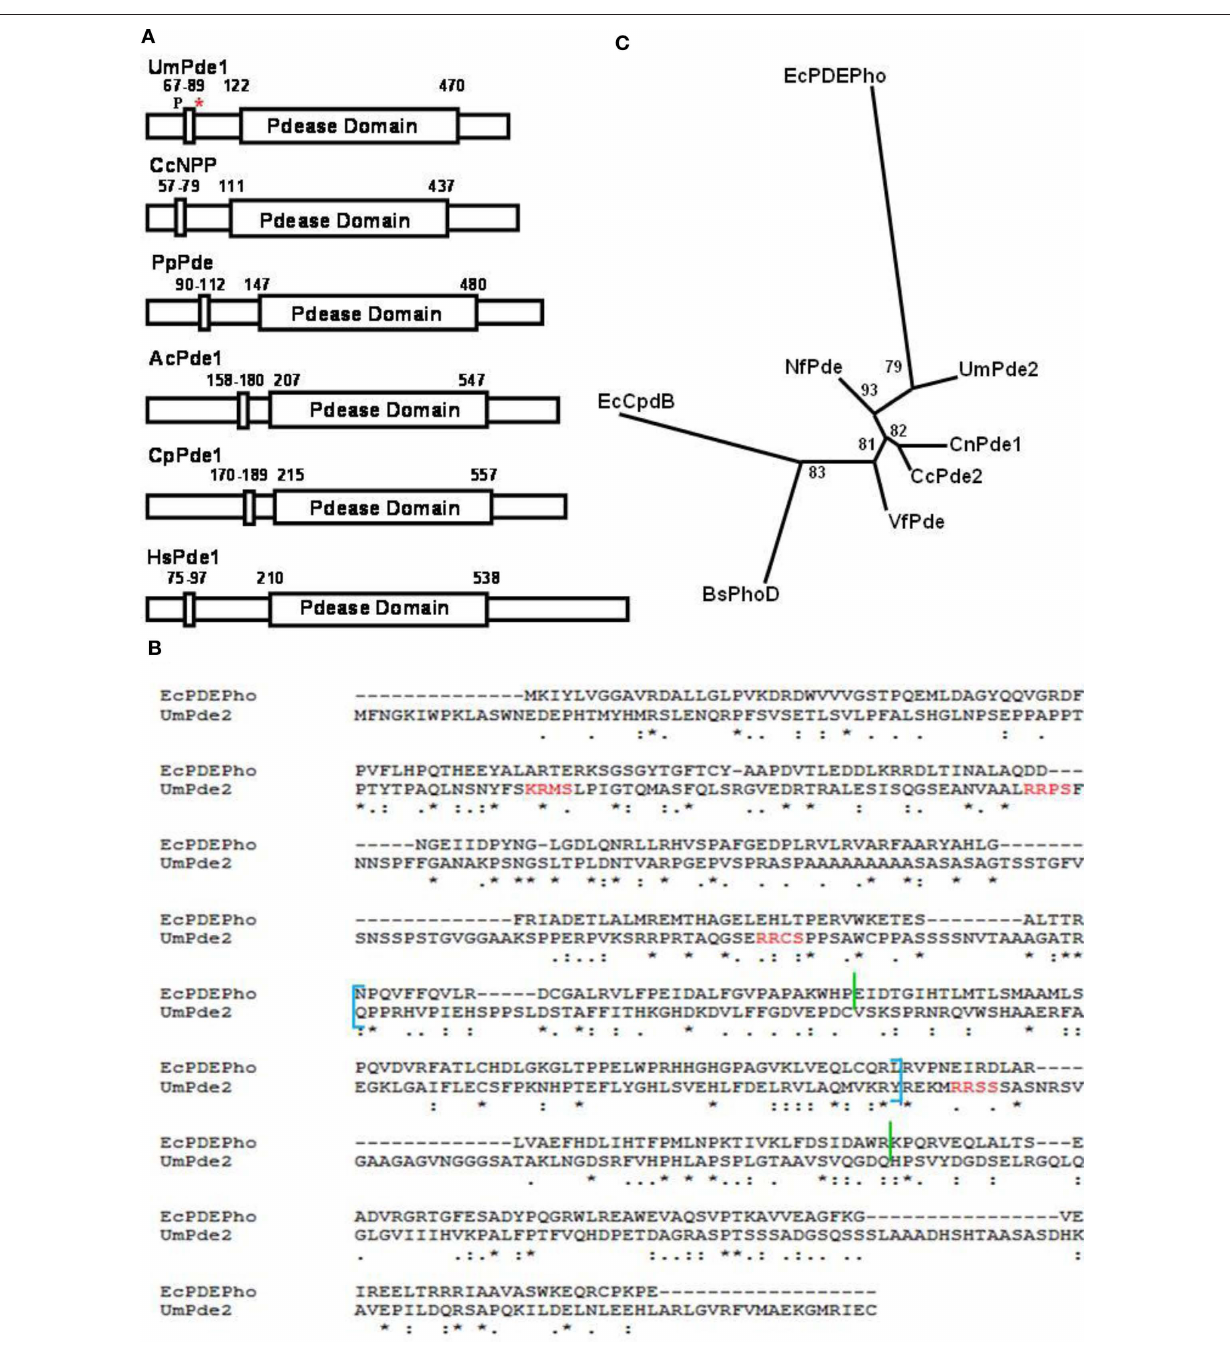
transferase and 2 ′ 3 ′ -cyclic phosphodiesterase/2 ′ nucleotidase/phosphatase. The putative pfam02112, cAMP phosphodiesterase II domain, of UmPde2 is delineated by blue square brackets, while the HDc domain of EcPDEPho is bounded by green vertical lines. The predicted PKA target sites in UmPde2 are highlighted in red. (C) Unrooted tree showing relationship of UmPde2 catalytic domain compared to those of two PDEs from basidiomycetous and one ascomycetous fungi, as well as those from several bacteria. The EcCpdB (Accession No. P08331) and BsPhoD (Accession No. AAB47803) represent enzymes shown to have both cyclic phosphodiesterase and nucleotide phosphatase or cyclic phosphodiesterase and alkaline phosphatase activities,